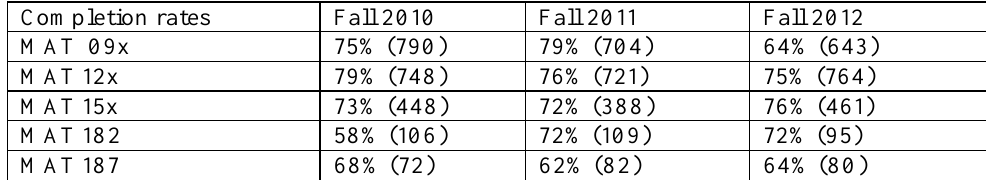
Aggregated Data Fall 2010 – Fall 2012: Completion